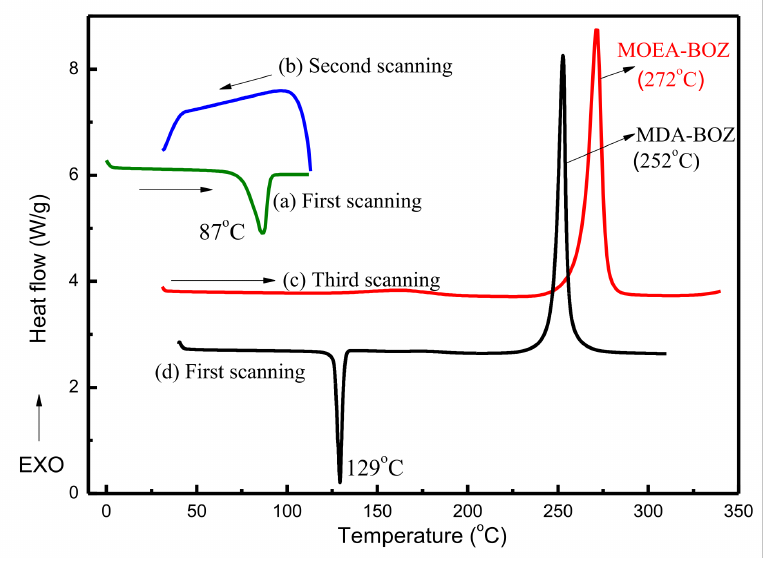
Figure 2. DSC curves of MOEA-BOZ ( a – c ) and MDA-BOZ ( d )